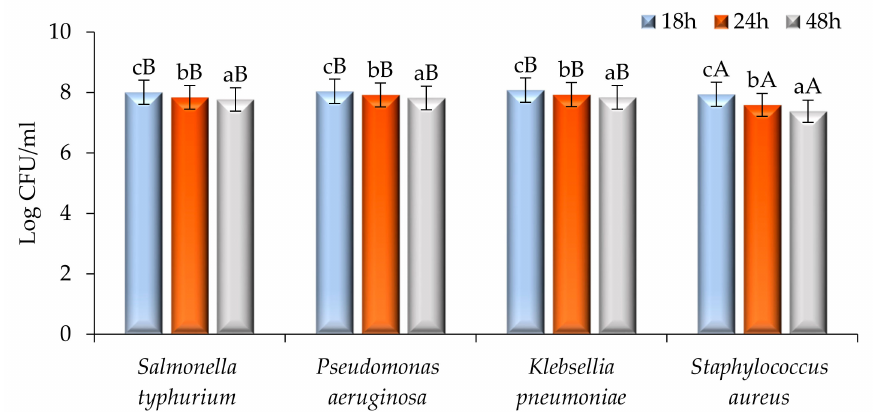
Figure 5. Time–kill kinetics of Woodfordia fruticosa flower’s dry extract against the growth of food pathogenic bacteria during different time intervals. Data are presented as means ± SEM ( n = 3); a–c: Means within the column with different lowercase superscripts are significantly different ( p < 0.05); A, B: Means within the row with different uppercase superscripts are significantly different ( p < 0.05) from each other.